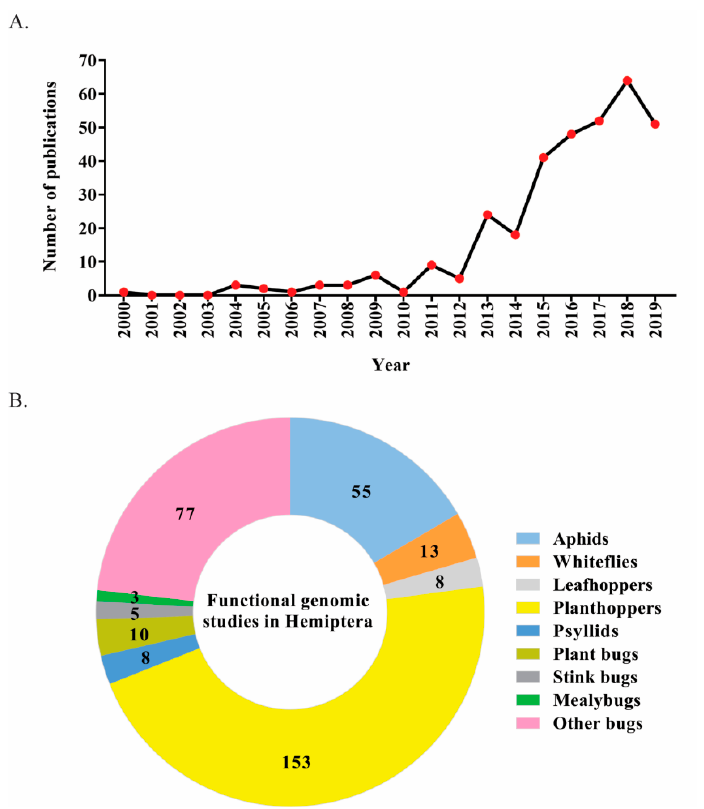
Figure 2. Dynamics of publications focused on RNAi-based functional genomics studies in major hemipteran pests. ( A ) The number of research publications for the past 20 years; ( B ) the number of functional RNAi studies in different hemipteran pests.